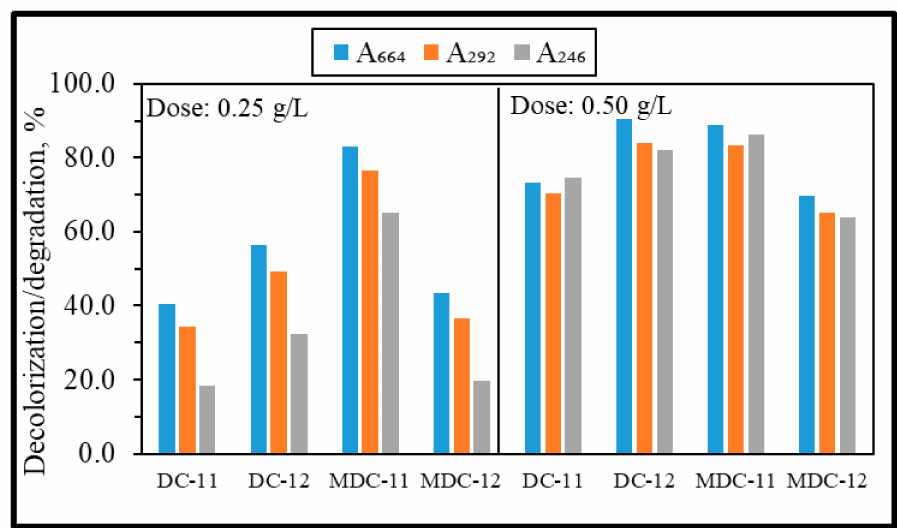
Figure 8. Dose-dependent decolorization/degradation efficiencies of MB onto DC-11, DC-12, MDC-11, and MDC-12 as expressed by all descriptive